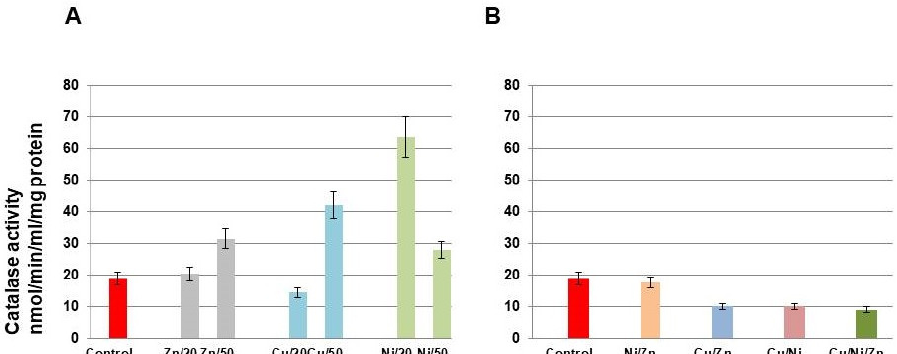
Figure 4. Catalase activity in the cell lysate of S. xiamenensis DCB2-1 under zinc, copper, and nickel single ( A ) and combination actions ( B ). Metal concentrations in single systems are 20 and 50 mg/L; metal concentrations in complex systems are 20 mg/L. The data presented are the mean values ± SD from three separate sets of experiments.